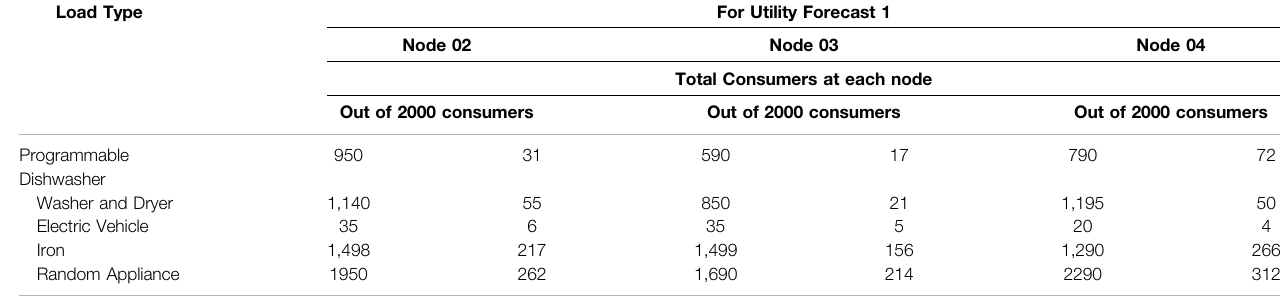
TABLE 3 | Number of reschedule forecasts in utility one.